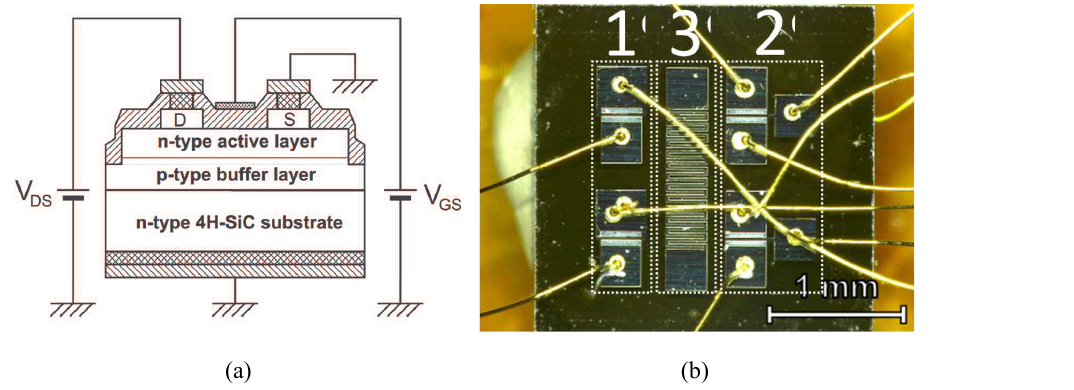
Figure 1. Schematic cross-sectional view of the studied MISiC-FET (a) , and top view of the sensor chip comprising four sensor devices (1: gate connected to drain, 2: variable gate) and a Pt100 temperature sensor (3) (b) .